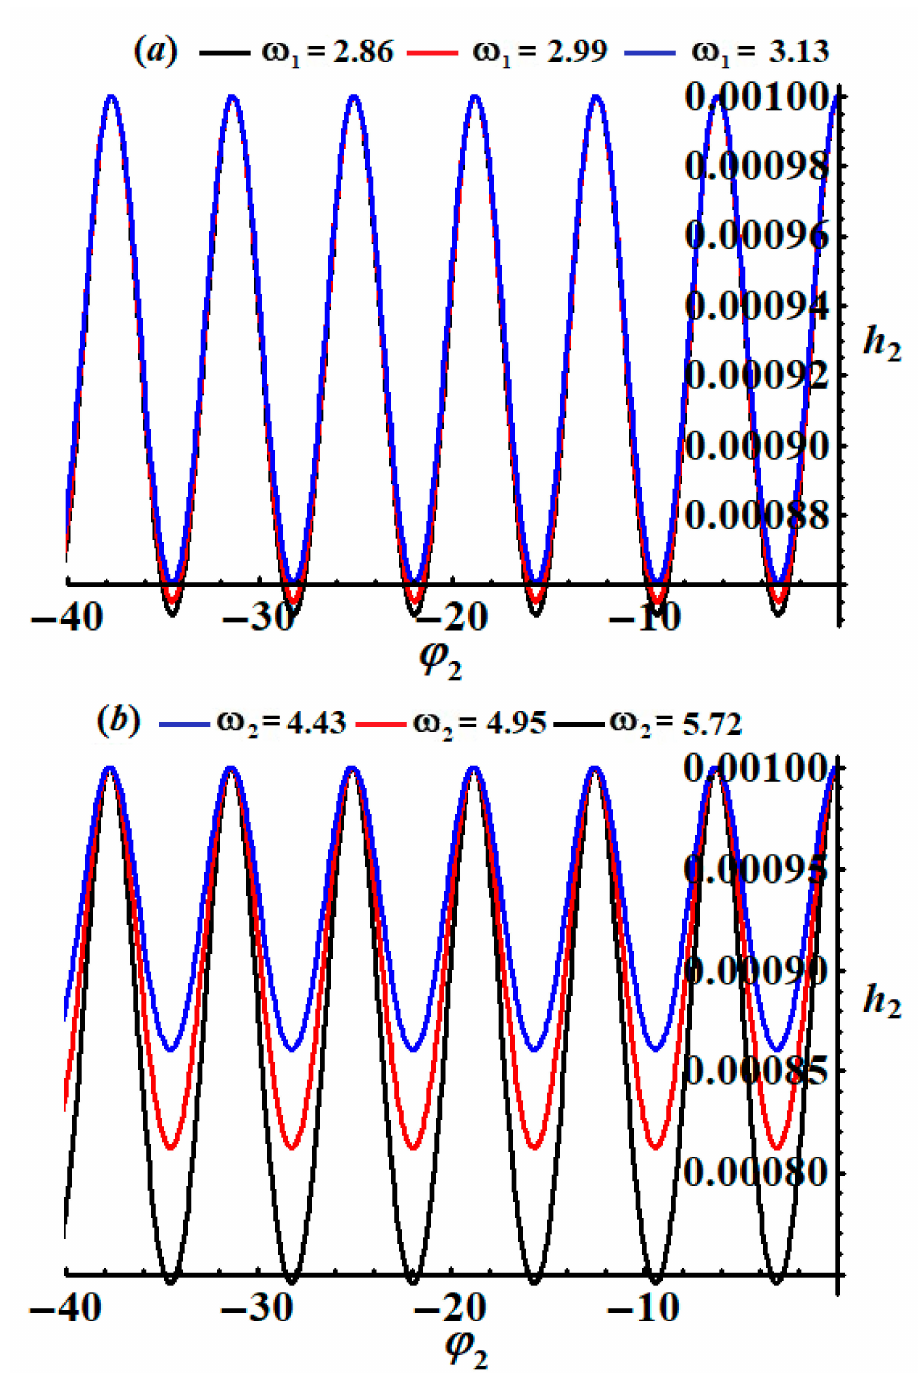
Figure 8. Clarification of the modulation of the amplitude h 2 as a function of ϕ 2 : ( a ) at ω 1 = ( 2.86,2.99,3.13 ) , ( b ) at ω 2 = ( 4.43,4.95,5.72 )